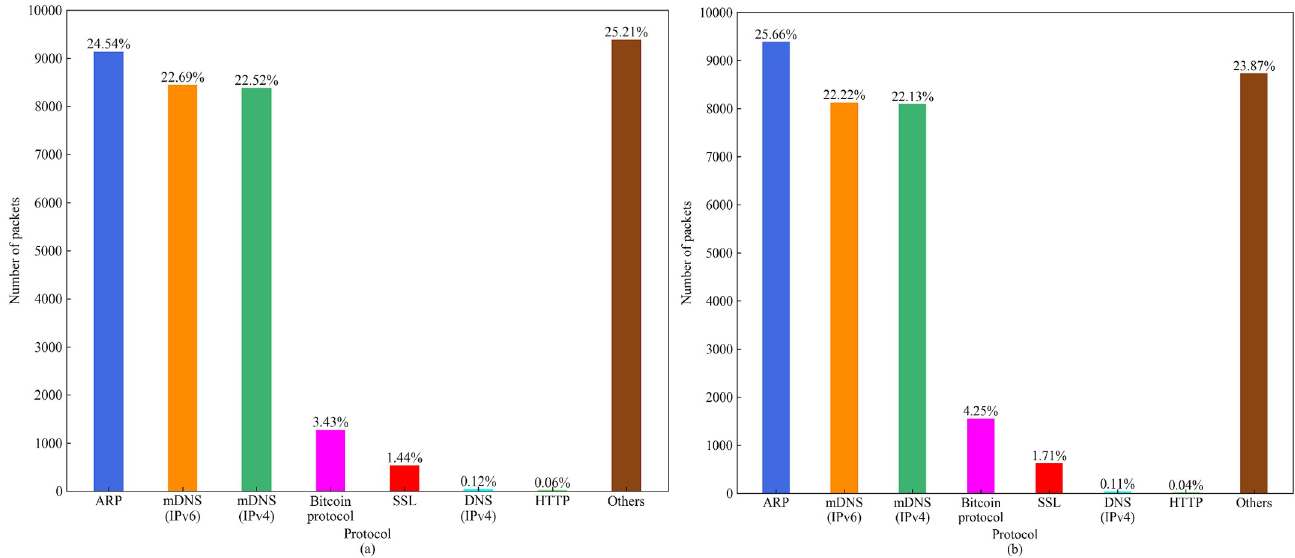
Fig 12. The network traffic of (a) running the Bitcoin Core client and (b) DUSTBot in the same network environment within 15 minutes.